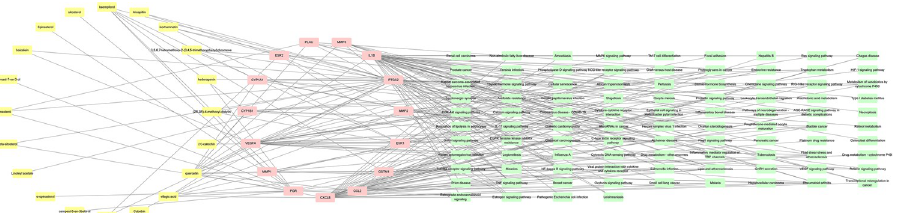
Fig 6. Component-target protein-pathway network. From left to right, the components of QUF, target proteins, and pathways are represented by the yellow, pink, and light green rounded rectangles, respectively. The edges show the connections between active compounds-protein and protein-pathway.